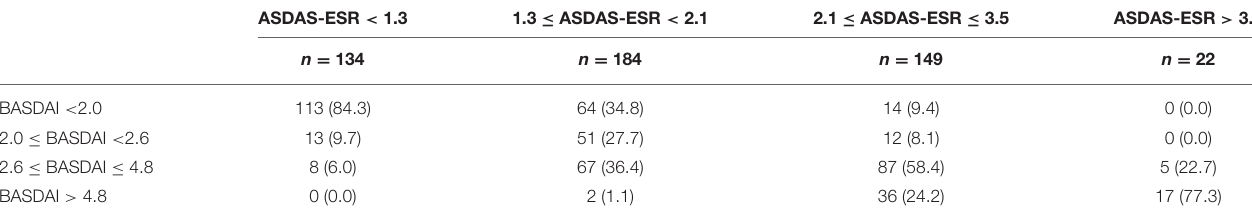
TABLE 5 | Degree of agreement between disease activity states based on BASDAI and ASDAS-ESR cut-off values. ASDAS-ESR < 1.3